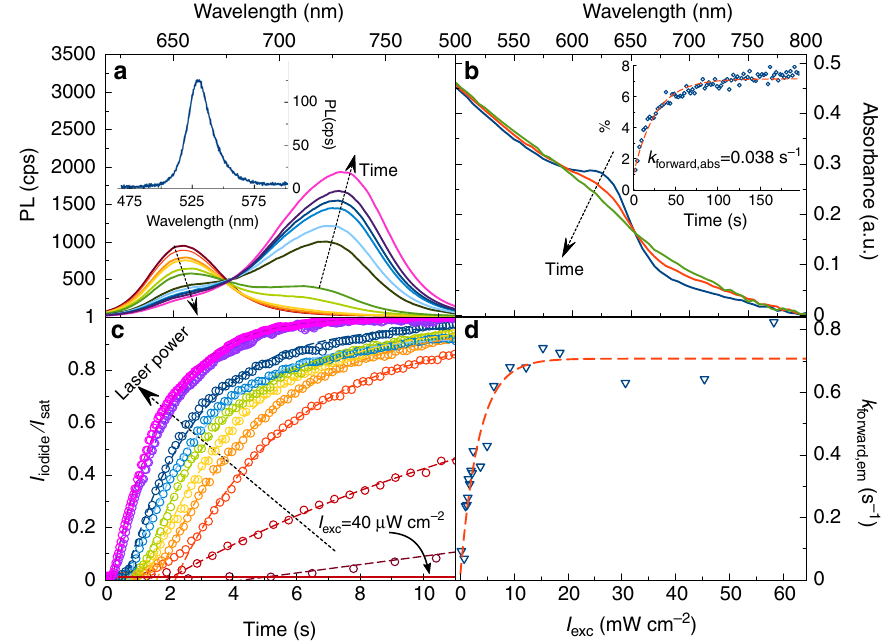
Fig. 1 Spectroscopic observations of halide phase segregation. a Time evolution of MAPb(I 0.5 Br 0.5 ) 3 (MA = CH 3 NH 3 + ) emission spectra (PL, photoluminescence) under 405 nm continuous wave excitation ( I exc = 20 mW cm − 2 ). Times for selected spectra (from red to purple ): 0.05, 1.41. 1.64, 1.69, 1.83, 1.93, 2.26, 2.40, 2.58, 2.68, 2.87, and 3.10 s. Inset : Emission spectra between 475 and 600 nm. b Corresponding time evolution of the MAPb (I 0.5 Br 0.5 ) 3 absorption spectra under 405 nm continuous wave (CW) excitation ( I exc = 25 mW cm − 2 ). Times for selected absorption spectra (from blue to green ): 0, 1, 30 min. Inset : Absorption-based phase separation kinetics from absorption changes at 720 nm where the dashed red line represents an exponential fi t to the data. c I iodide /I sat ( I iodide – iodide-rich emission intensity, I sat – saturation emission intensity) under different I exc ( I exc – excitation intensity). Dashed lines are fi ts using Eq. (4). The bottom solid red line shows I iodide /I sat when I exc = 40 μ W cm − 2 . Excitation intensities for selected curves (from red to purple ): 0.27, 0.79, 1.05, 1.46, 1.56, 2.27, 3.81, 5.04, 18.56, 57.28 mW cm − 2 . d I exc -dependent emission-based fi rst order rate constant for phase separation. The dashed red line represents a fi t to the data using Eq.